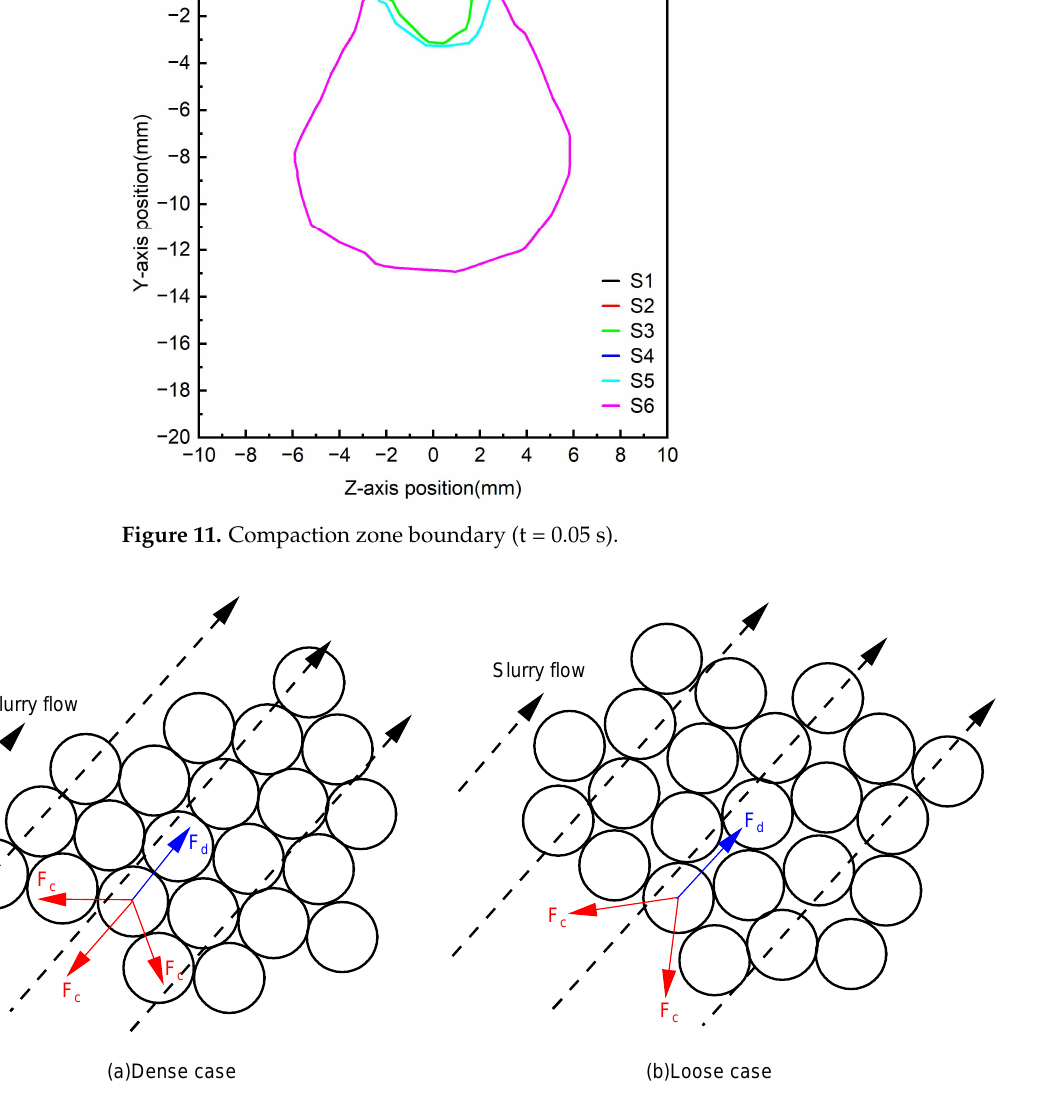
Figure 12. Schematic diagram of slurry flow.